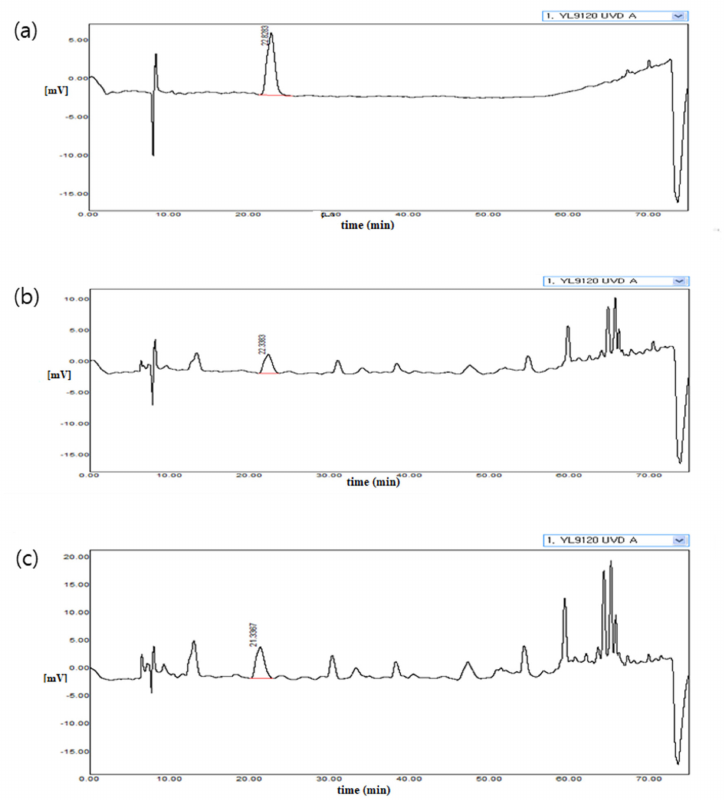
Figure 1. HPLC chromatogram of two extracts and aloesin as a standard: ( a ) aloesin (20 ppm); ( b ) BW, the hot water extract of aloe skin leaf at 100 ◦ C for 24 h; ( c ) BF, the fermented extract of aloe skin leaf fermented with L. plantarum BN41 at 37 ◦ C for 3 days and further extracted by an ultrasound generator at 20 kHz for 4